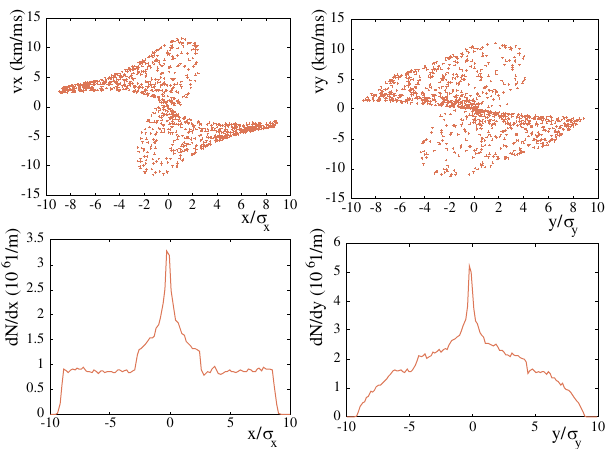
FIG. 60. (Color) Snapshot of horizontal (left) and vertical (right) electron phase space (top) and their projection onto the position axes (bottom) at the end of a bunch passage in the SPS